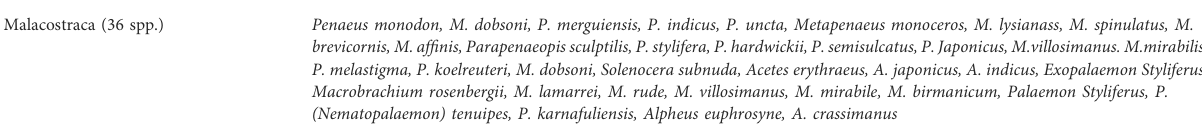
TABLE 8 Diversity of shrimp (36 spp.) and Crab (16 spp.) in the estuarine waters of Bangladesh. Shrimp Family Species Malacostraca (36 spp.)